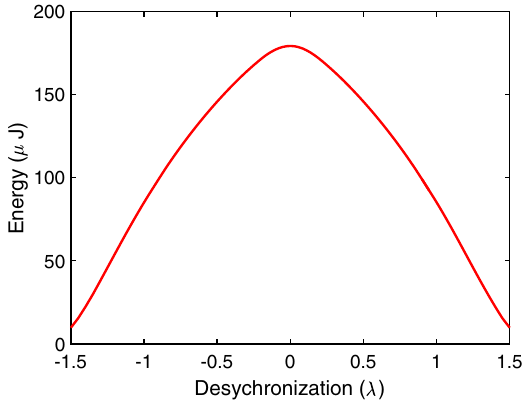
FIG. 6. The output laser energy as a function of desynchronism.